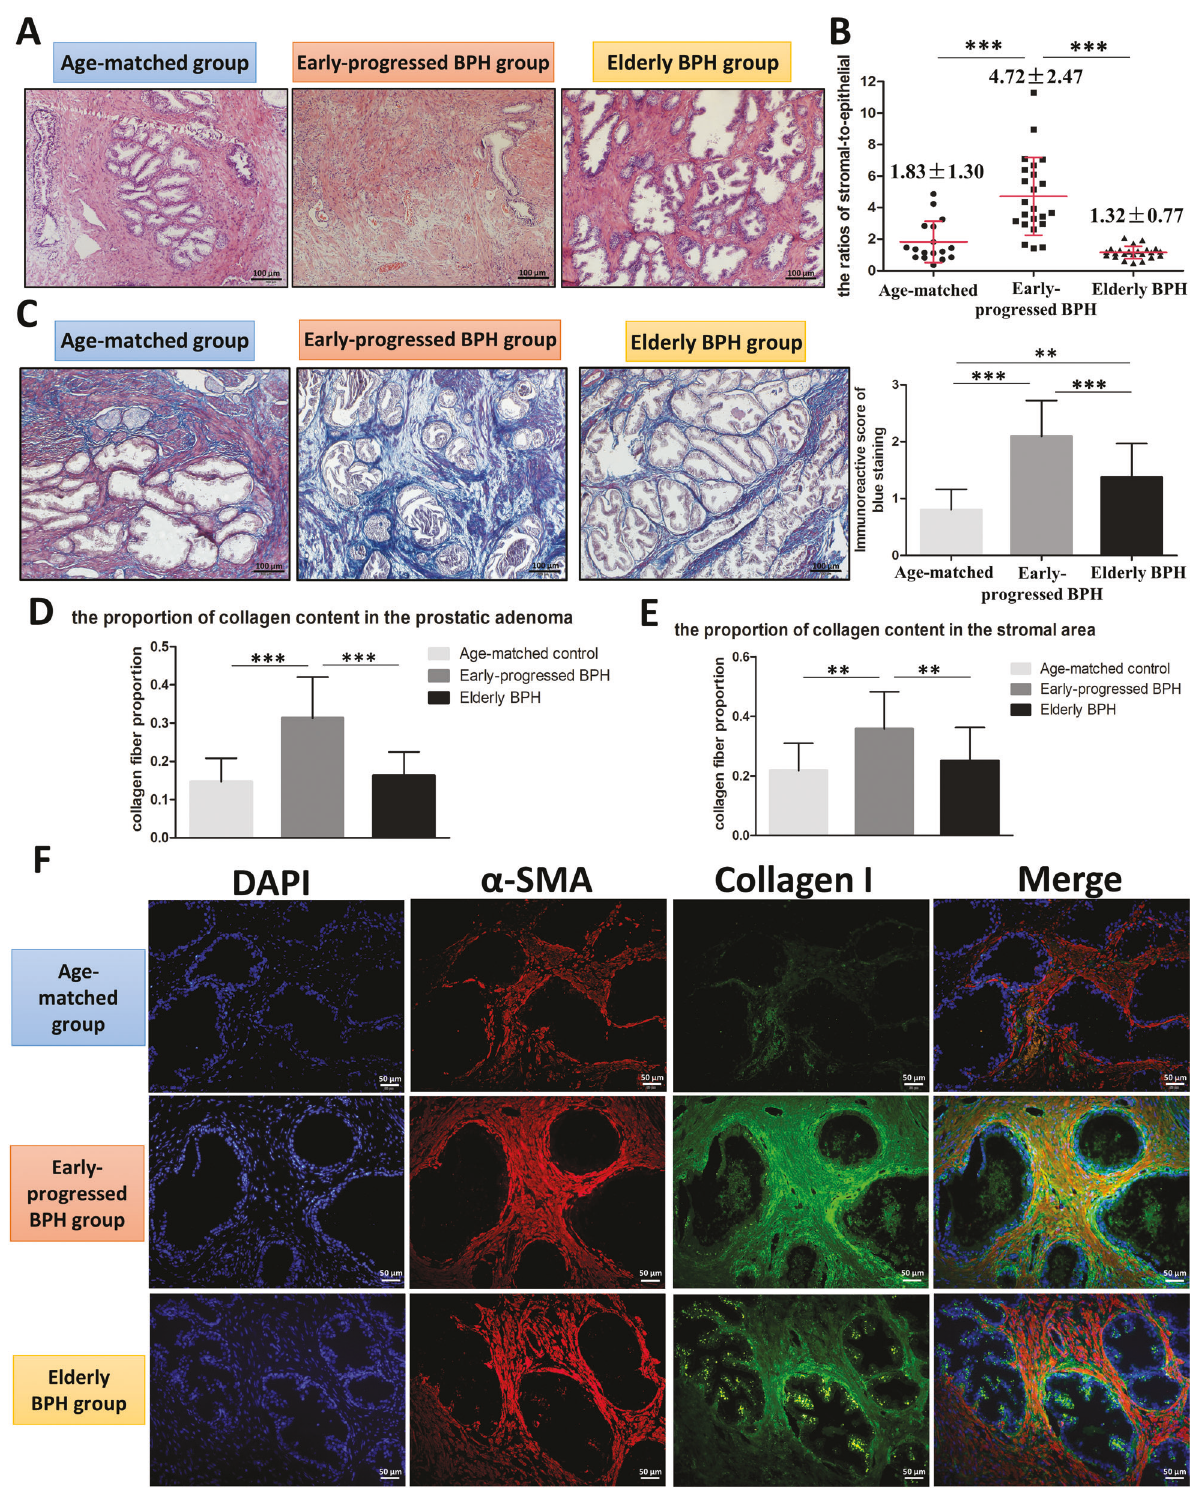
Fig. 1 Histological analysis of prostatic specimens from the three groups. A H&E staining of paraf fi n-embedded prostatic tissue specimens from the three groups of patients. Scale bar: 100 μ m. B Computer image analysis for the ratio of stromal-to-epithelial hyperplasia in the three groups. The variance was similar between the groups. *** P < 0.001. C Masson ’ s trichrome staining for prostatic tissue specimens from the patients of three groups. Scale bar: 100 μ m. Right bar graph is the IOD of collagen fi ber with blue staining. The variance was similar between the groups. ** P < 0.01, *** P < 0.001. D, E Computer image analysis of Masson ’ s trichrome staining and the ratio of the stromal-to-epithelial area. The proportion of collagen fi ber in the total prostatic adenoma ( D ) and in the stromal area ( E ) of the three groups. The variance was similar between the groups. ** P < 0.01, *** P < 0.001. F Prostatic tissues from the three groups of patients were stained for α -SMA (red) and collagen I (green), and the nuclei were counterstained with DAPI (blue) by immuno fl uorescence. Merged images indicate a myo fi broblastic phenotype. Scale bar: 50 μ m. Cell Death and Disease (2022)